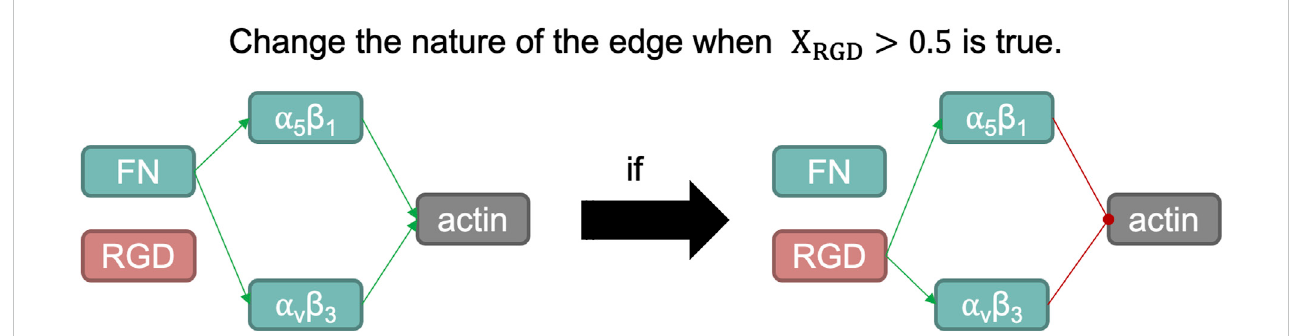
FIGURE 4 Schematic representation of the switch induced when the normalized activation of RGD node is larger than 0.5. Fibronectin (FN) is a structural protein present in articular cartilage that binds integrins α 5 β 1 and α v β 3 , which in turn helps organize the actin cytoskeleton. One of the integral functions of the actin micro fi lamentsinchondrocytesisinthemaintenanceofitsphenotype.However,RGDpeptides, whenboundwithsuchintegrins,induceacatabolic pathway in chondrocytes. Such action is summarized by inducing a negative regulation on the actin node in our network modelling, as it is a potent regulator of the chondrogenic